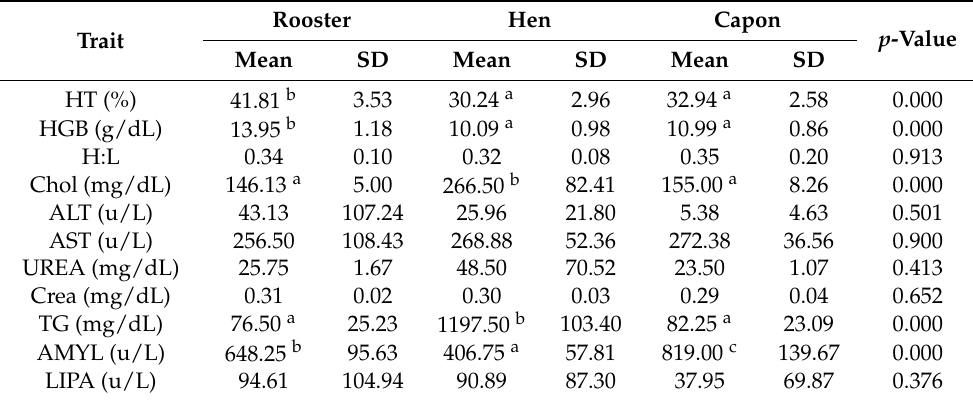
Rooster Hen Capon